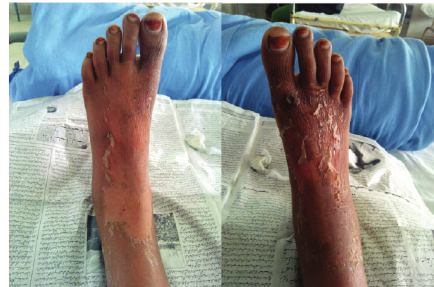
Figure 3: Desquamative rash on the feet of the